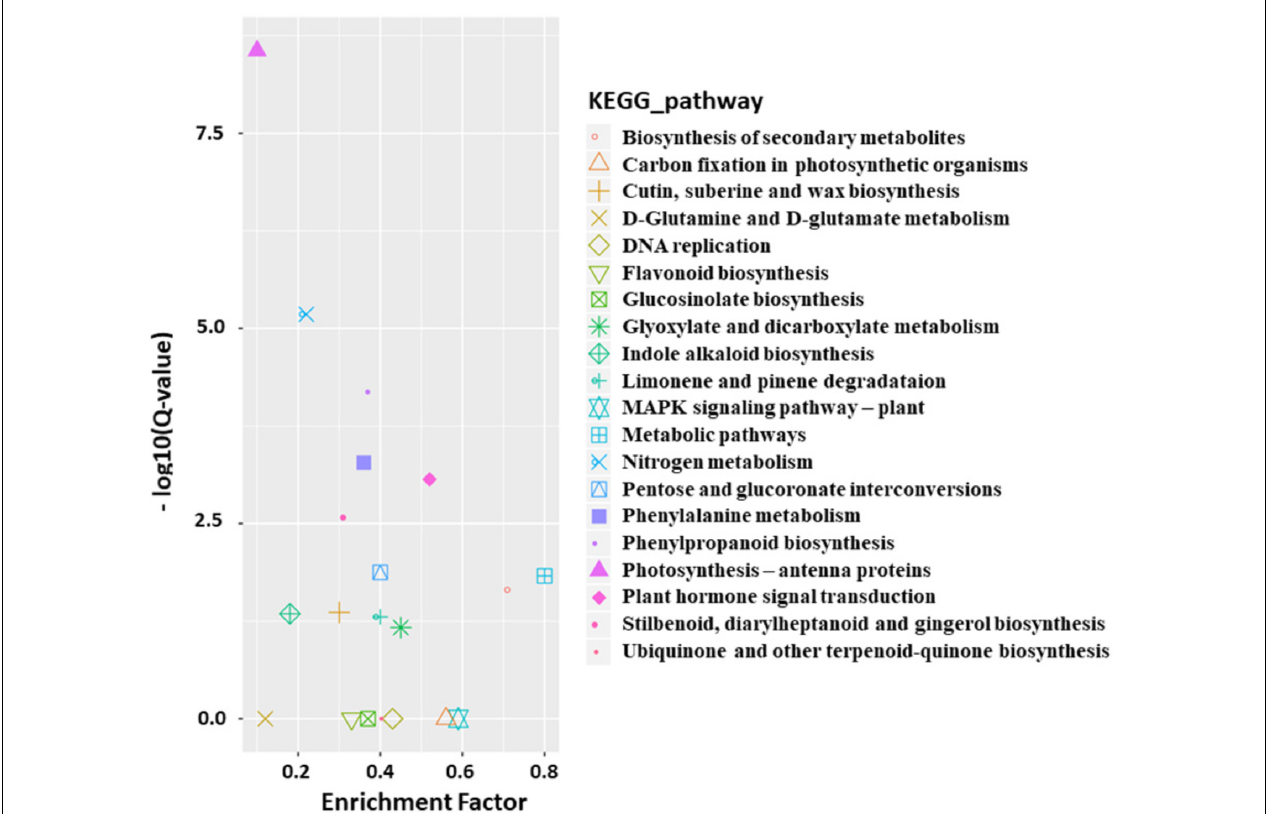
FIGURE 5 | Over-represented KEGG terms of the differentially expressed genes (DEGs). KOBAS software was used to test the statistical enrichment of DEGs in KEGG pathways (Mao et al.,